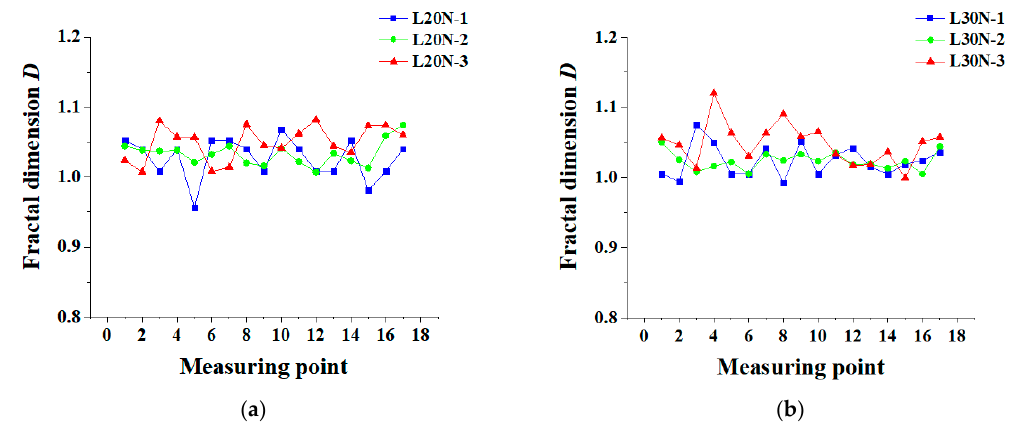
Figure 6. Variation of fractal dimension D : ( a ) L20N; ( b ) L30N.